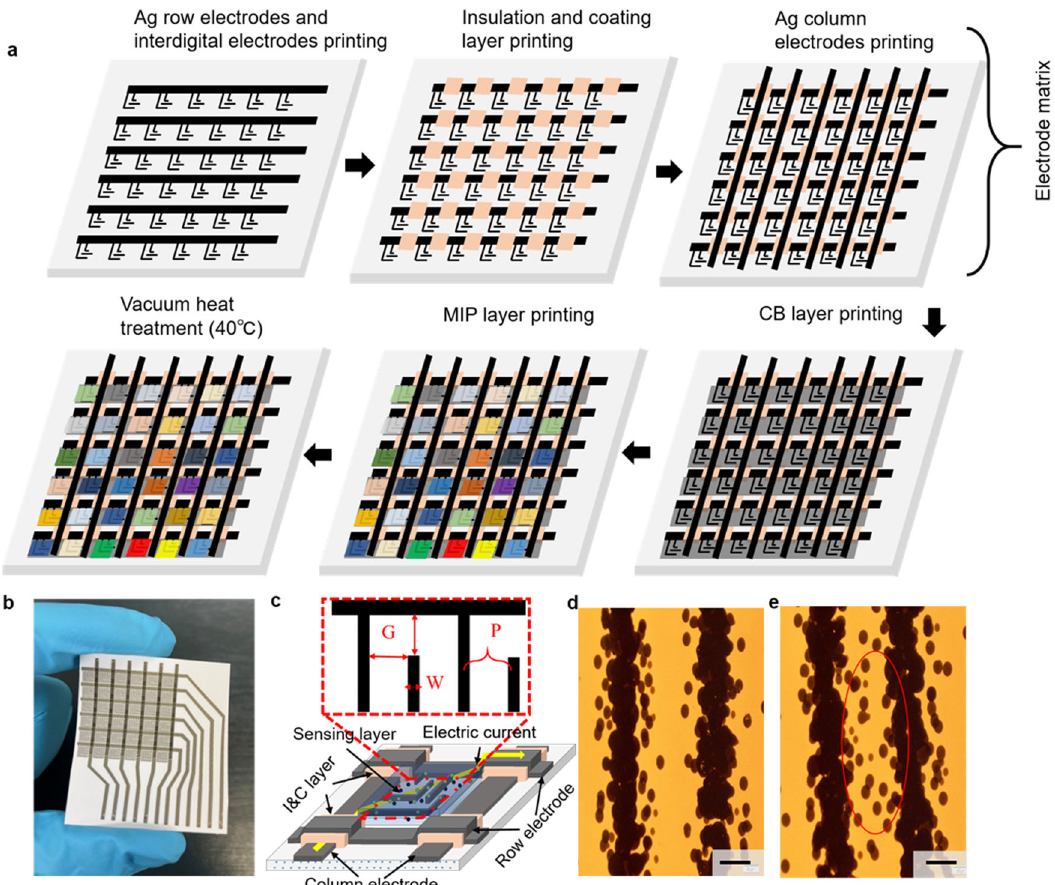
Fig. 1 Printed electrode matrix and sensor matrix. a Schematic of printed sensor-matrix fabrication process. b Photograph of the completed sensor matrix. c Schematic of the silver interdigital electrode with pitch ( P ), gap ( G ), and width ( W ) parameters. d Microscope image of G = 230 μ m silver interdigital electrodes. e Microscope image of G = 180 μ m silver interdigital electrodes and interdigital gap showing evidence of silver ink microsplashing (scale bar = 100 μ